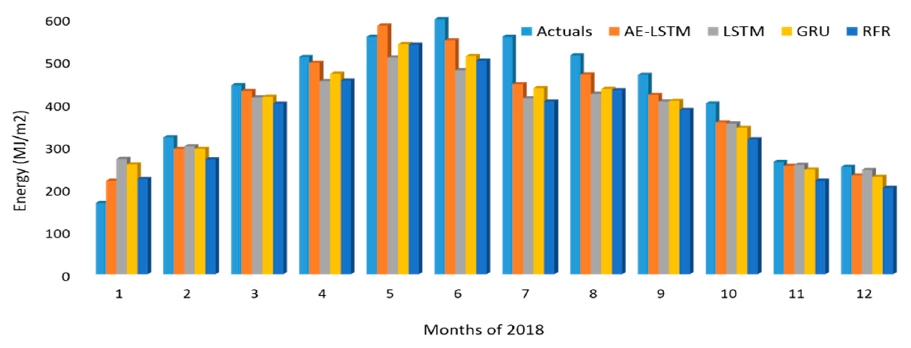
Figure 15. PV energy potential estimation for the year 2017.